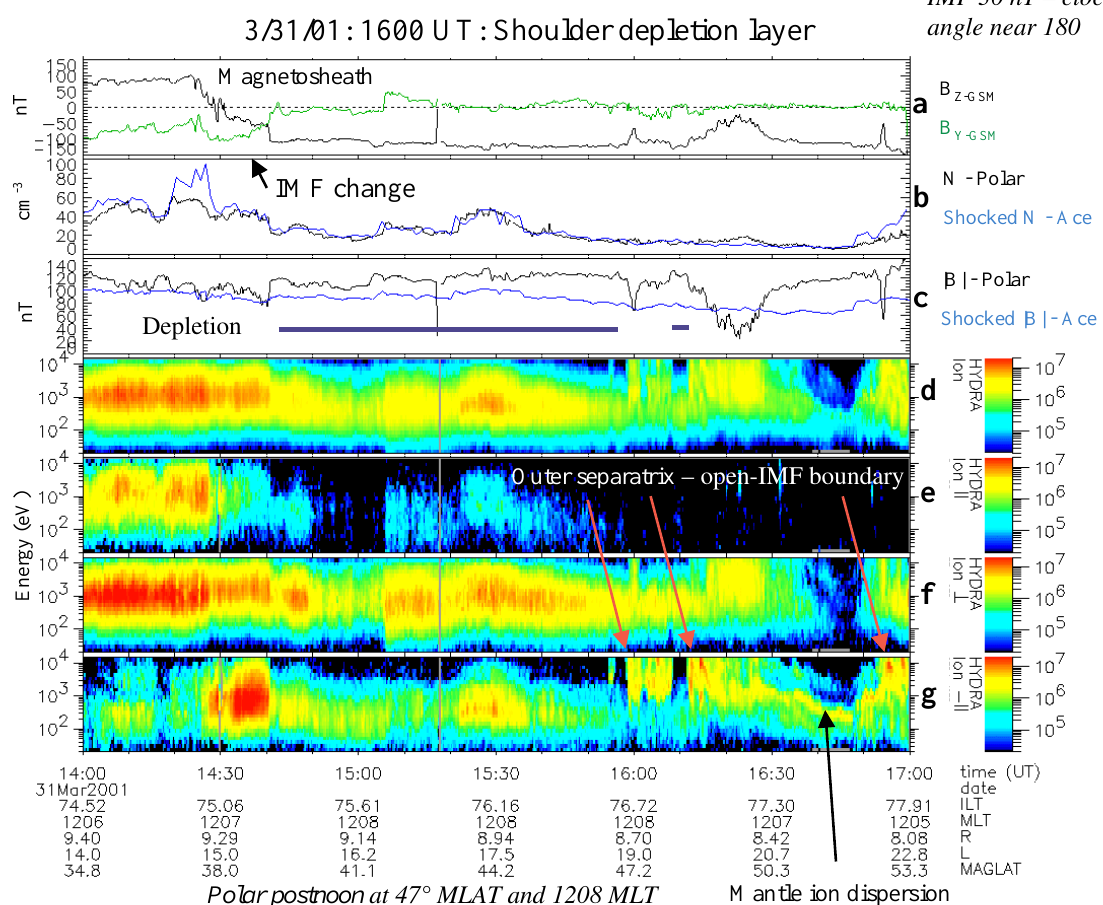
Fig. 10. Polar data from 31 March 2001, inbound above the Northern Hemisphere cusp showing a shoulder depletion layer. The format is the same as in Fig. 1. In this case (later in the day from the data shown in Fig. 9) the dipole was tilted toward the Sun, as Polar crossed from the magnetosheath to the